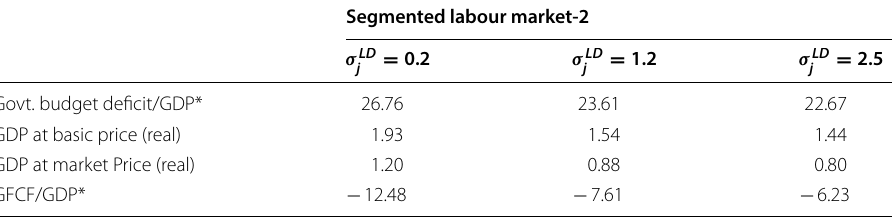
Real GDP is calculated applying GDP deflator computed from SAM * GDP at basic price